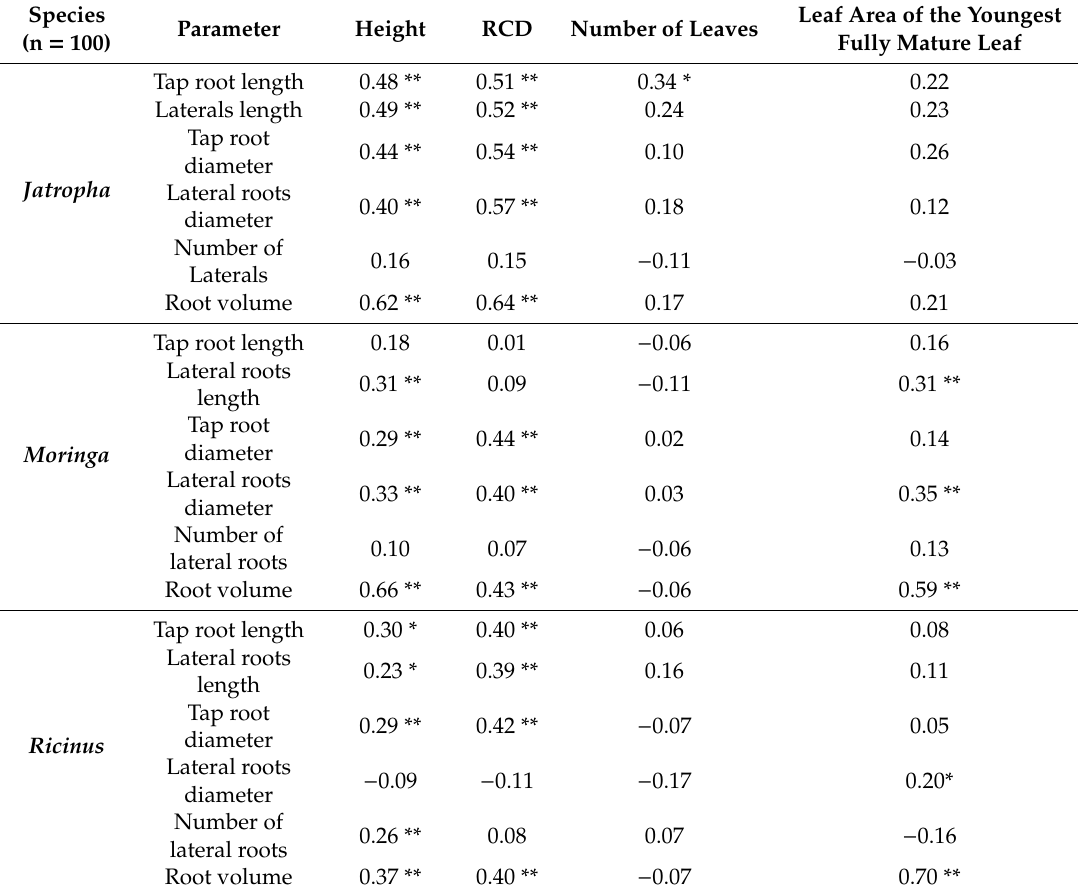
Table 4. Linear correlations between above- and belowground data of Moringa oleifera , Jatropha curcas and Ricinus communis seedlings 63 days after germination.